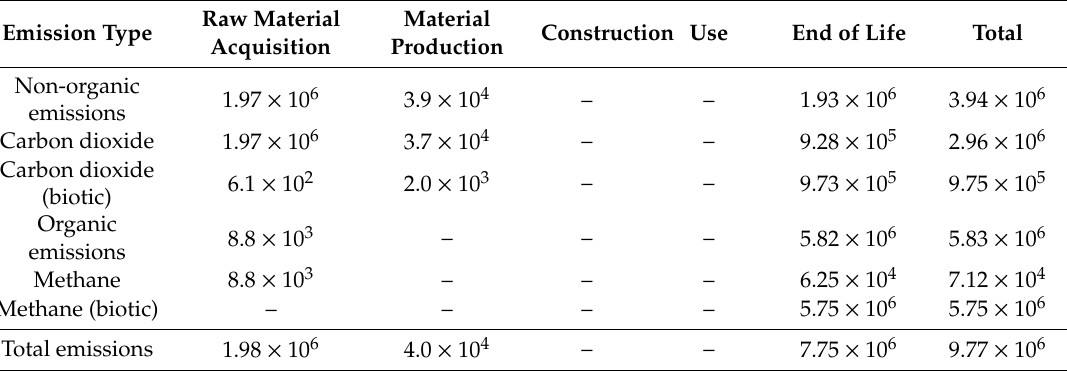
Table 8. Emissions to air by the concrete building (kg CO 2 eq.).